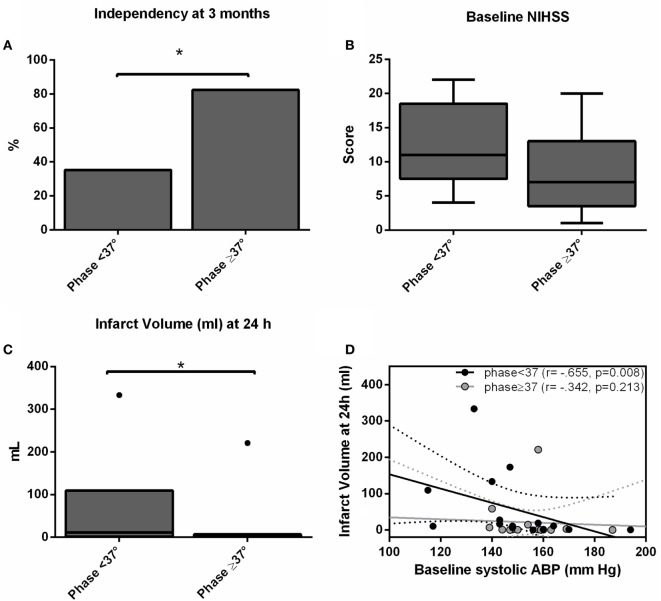
Independency at 3 months (A), baseline National Institutes of Health Stroke Scale score (B) and infarct volume (C) accordingly subgroups of worse (phase < 37°) and better (phase ≥ 37°) dynamic CA (dCA) on the ischemic hemisphere. Bars represent % and box-and-whiskers plots medians/interquartile ranges. Significant results (p < 0.05) are topped by asterisks. (D) Scatter plot showing infarct volumes at 24 h (ml) plotted against baseline systolic arterial blood pressure level separated by subgroups of worse (phase <37°, black dots) and better (phase ≥37°, gray dots) dCA, and respective linear regression lines and 95% confidence interval.